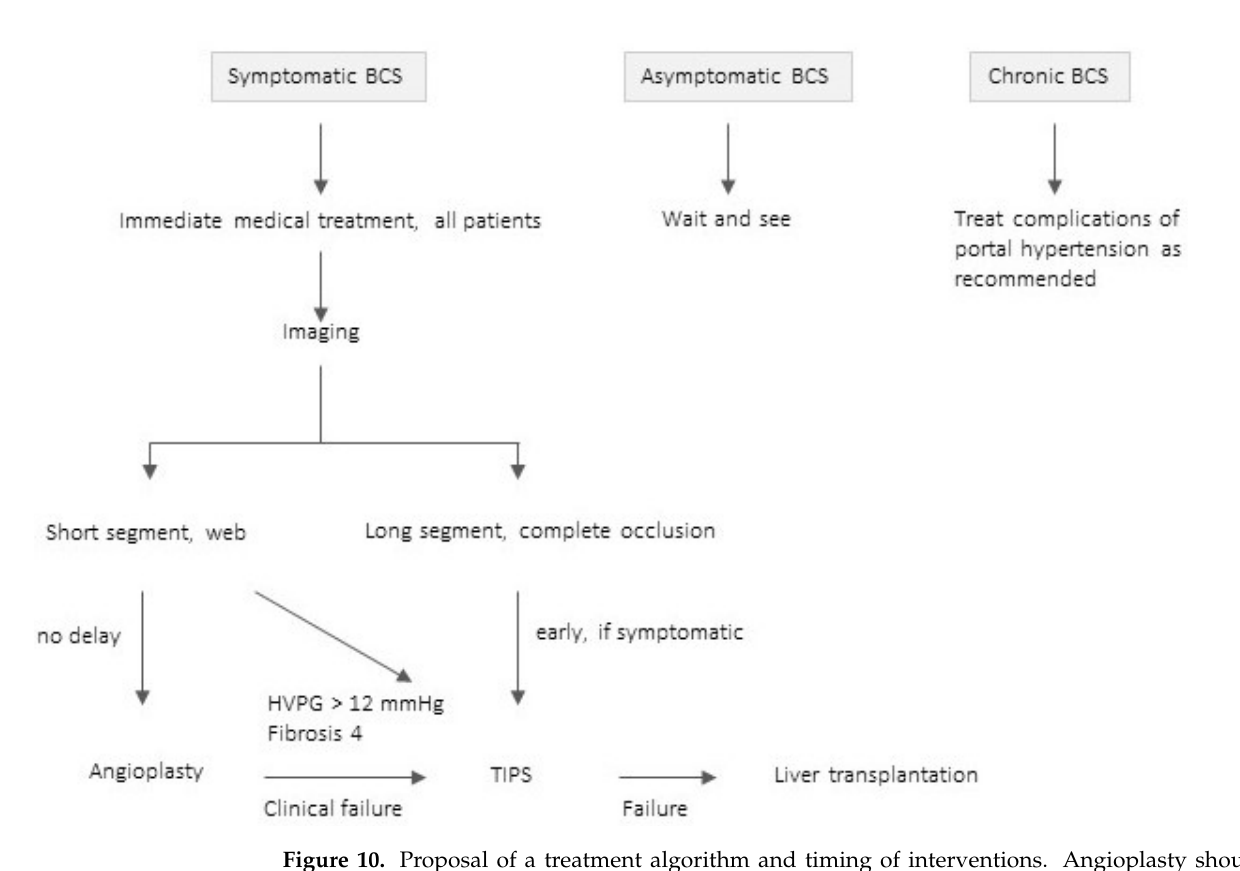
Figure 10. Proposal of a treatment algorithm and timing of interventions. Angioplasty should be performed without delay if a web-like BCS has been diagnosed. After successful angioplasty (demonstrated by lack of a significant gradient across the stenosis), the hepatic venous pressure gradient should be determined. An elevated gradient (>12 mmHg) should indicate the need for a transjugular liver biopsy, and, in case of advanced fibrosis, a TIPS should be implanted. The timing of the TIPS in patients with long-segment BCS may depend on the clinical severity of the disease. In symptomatic patients (liver failure, ascites, varices), early TIPSs may be indicated without waiting on their response to medical treatment.